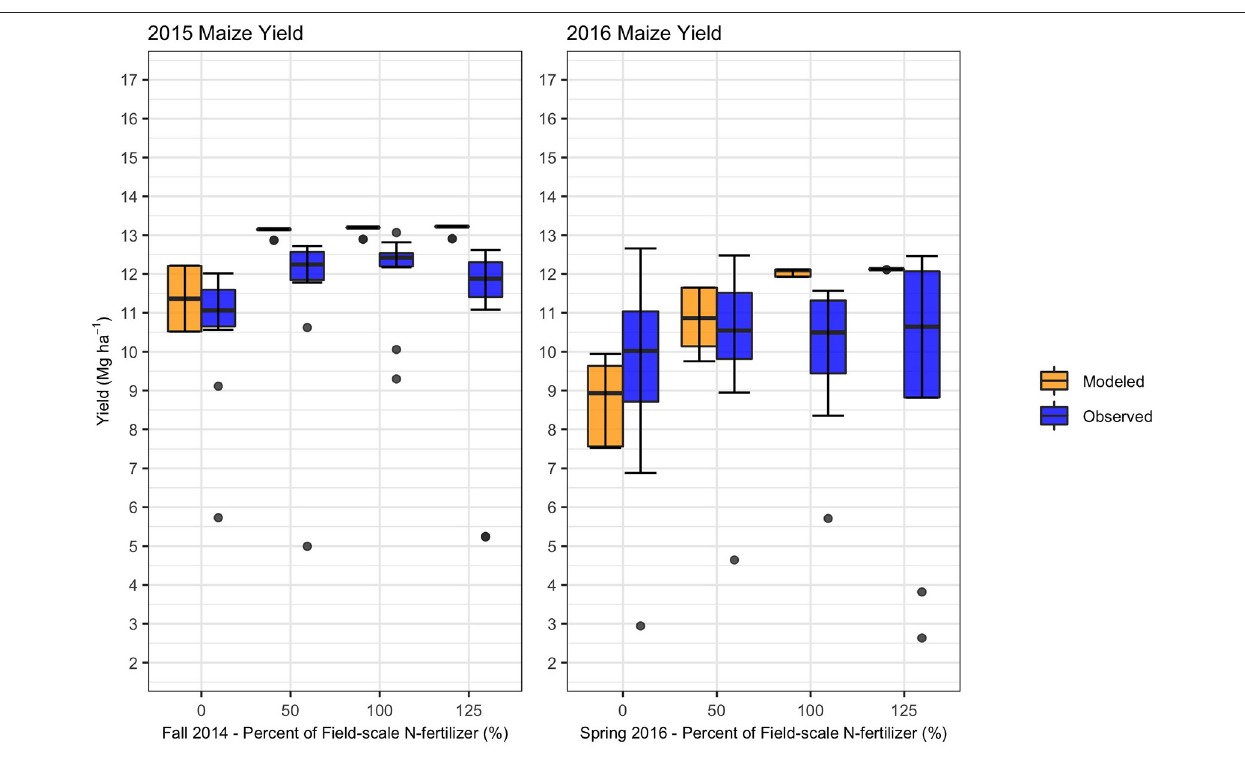
FIGURE 6 | Modeled and observed yield data associated with the four N-fertilizer treatments corresponding with 0, 50, 100, and 125% of the field-scale N-fertilizer rate applied during the fall of 2014 and the spring of 2016. Two replicates of each N-treatment were applied in randomized adjacent plots within the six zones located in an Iowa field (see Figure 2